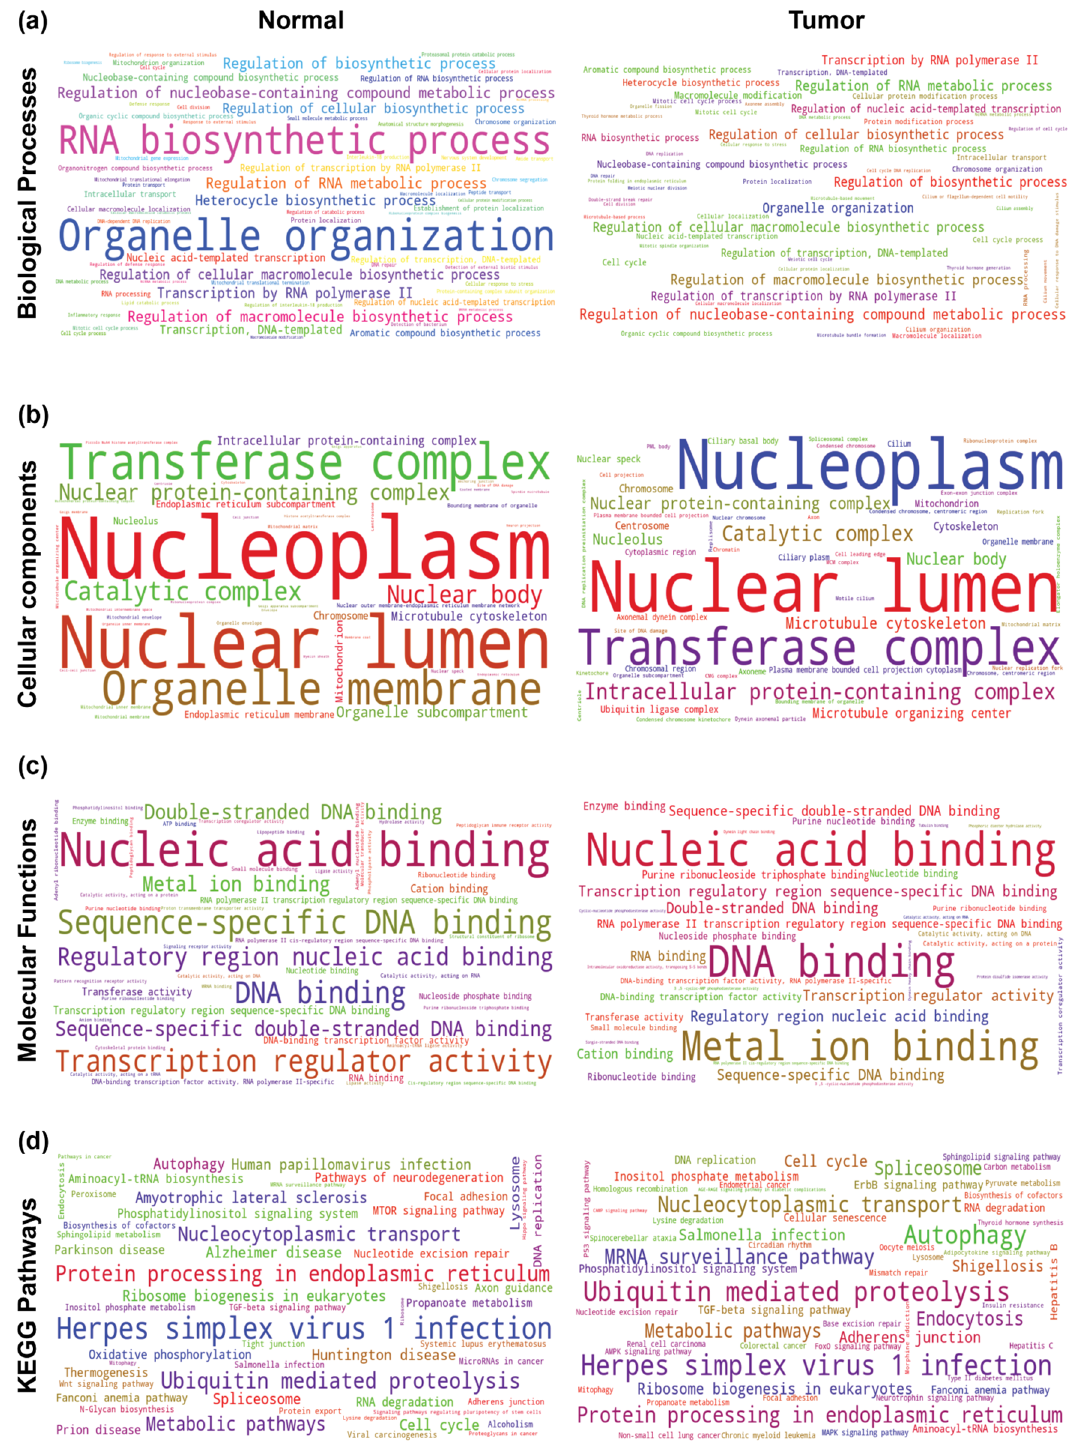
Figure 10. Gene Ontology (GO) and KEGG pathway analyses of genes co-expressed with THAP9 in normal vs. tumor samples. The enrichment test was performed for normal vs. tumor samples (for each cancer) using the ShinyGO for the top 10 enriched terms, with the significance cutoff for adjusted p -values bring set at 0.05. The font sizes in the word cloud are proportional to their frequency after the enrichment rates were merged for all cancers (left side for normal samples and right side for tumor samples). Word clouds of enriched GO terms in ( a ) the biological process category, ( b ) cellular component category, ( c ) molecular functions category, and ( d ) KEGG pathways.